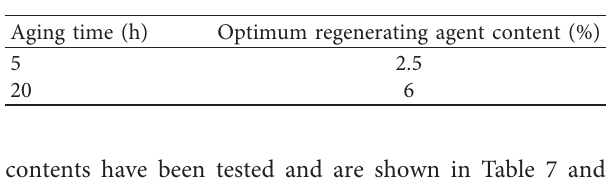
Figure 2: Index curve of regenerating asphalt in different regenerating agent contents. Table 4: Optimum contents of regenerating agent in different aging